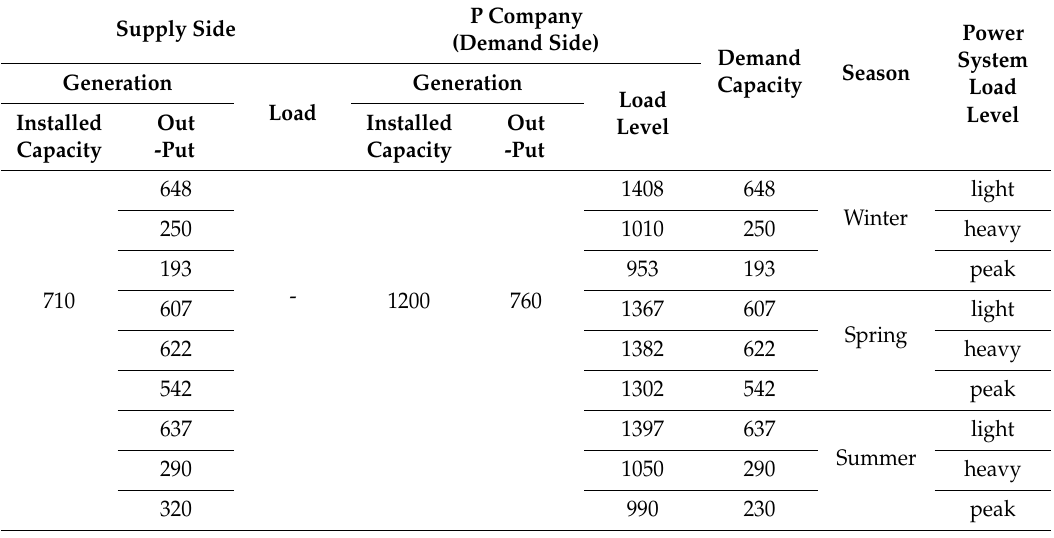
Table 7. Simulation data of the P steel company.